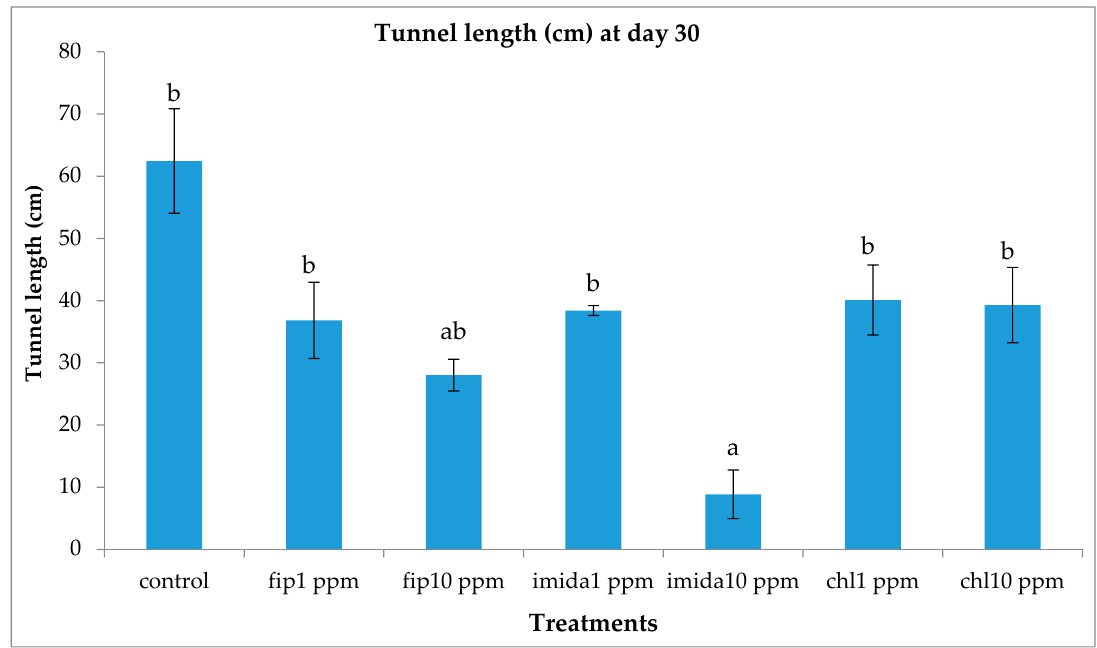
Figure 8. Mean tunnel length (±SEM) on the bottom foraging container at the end of the one-month (12 days for fip10 ppm) test. Means with the same letters are not significantly different ( p > 0.05) using Tukey’s HSD means separation.